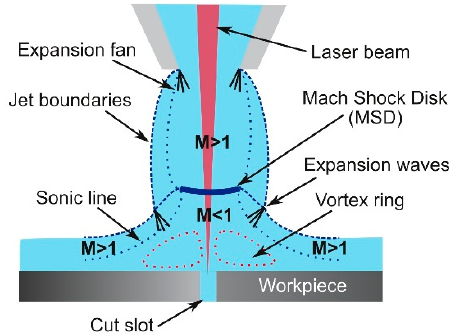
Figure 8. Gas flow structure after exhausted by a conical nozzle just at the entry of the cut kerf.